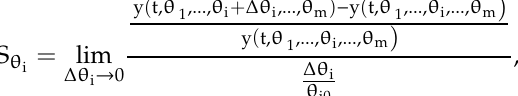
( b ) Figure 5. Sensitivity curve of the parameter to be identified: ( a ) sensitivity curve of active power of the parameter to be identified; ( b ) sensitivity curve of reactive power of the parameter to be identified. From the trajectory sensitivity shown in Figure 5, it can be seen that the response of active current recovery slope is intense and the response of reactive current support coefficient is small at the instant of active power change, while the response of reactive current support coefficient is intense and the